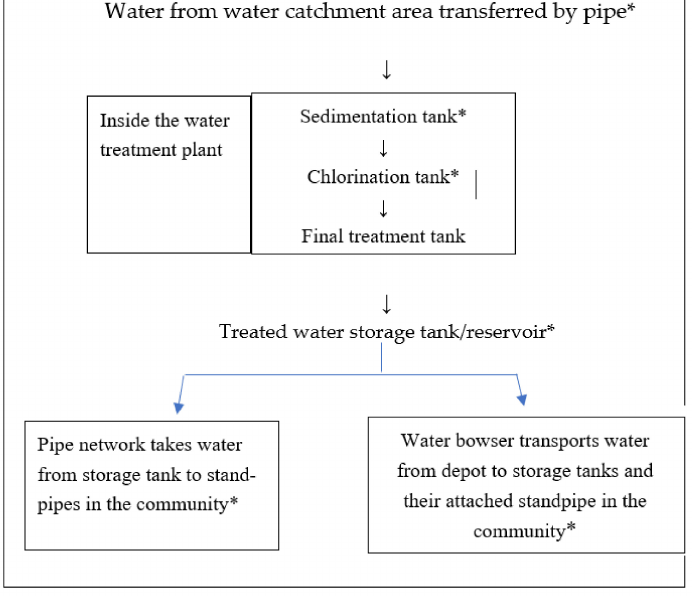
Figure 1. Flow diagram of water travelling from the catchment area of public water company to standpipes in Freetown Sierra Leone and the stages at which the water samples were taken. * indicates where water samples